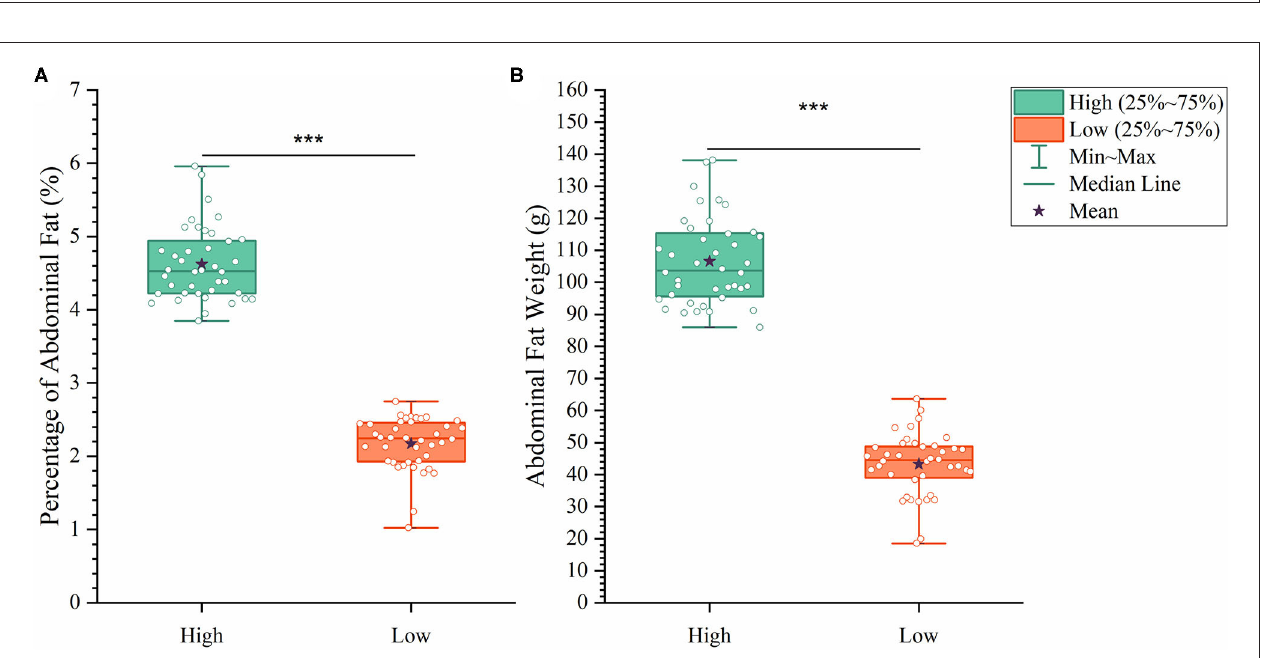
FIGURE 3 | The differences between the high and low groups in percentage of abdominal fat (A) and abdominal fat weight (B) . *** P < 0.001.